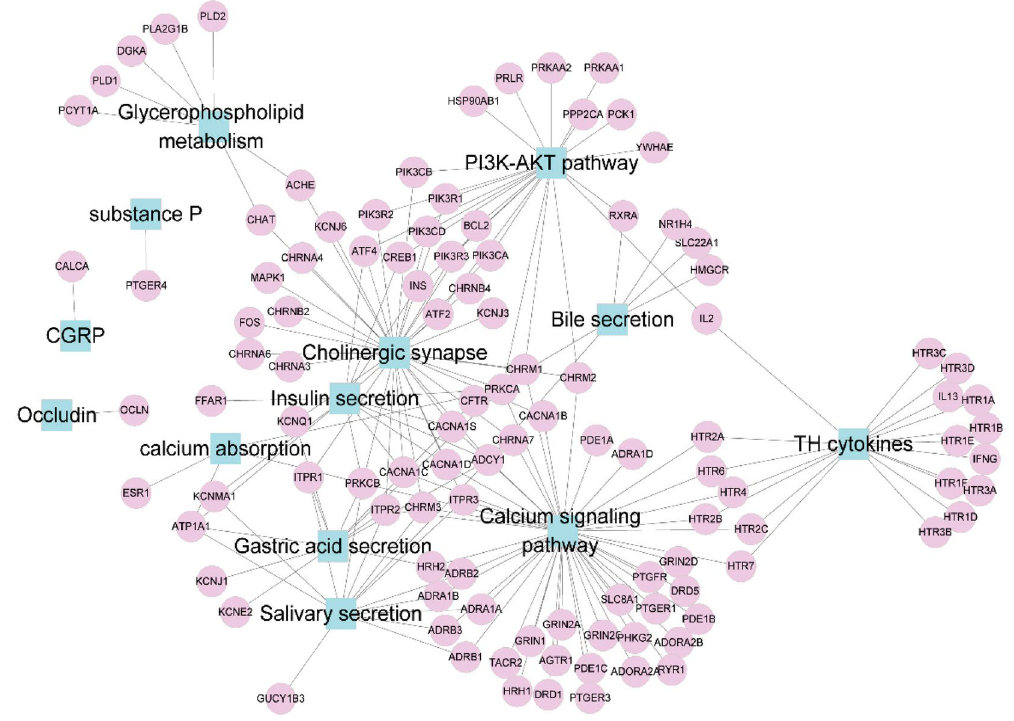
Figure 1. Network pharmacology prediction result of the efficacy of XiaoErFuPi (XEFP)